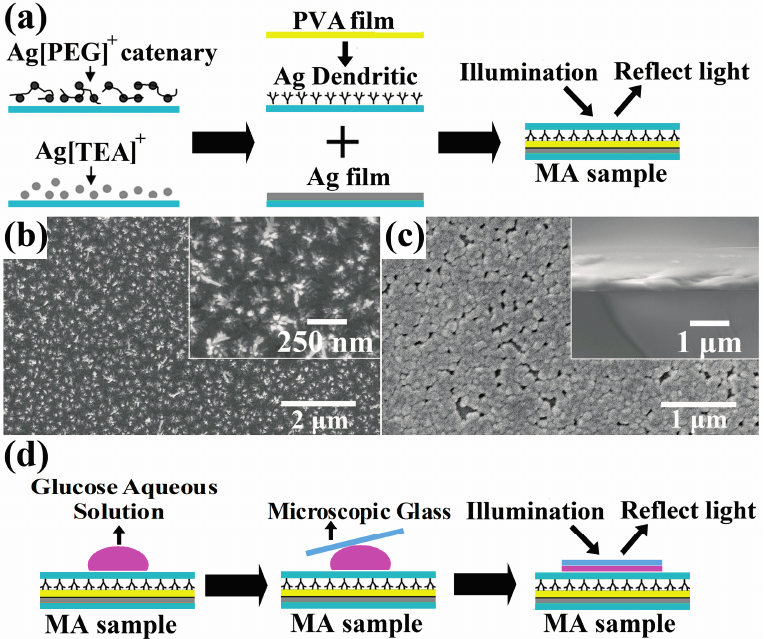
Figure 1. ( a ) The fabrication process of the multiband visible MA; ( b ) Scanning electron microscope (SEM) image of the prepared silver dendritic units—the illustration is an enlarged drawing of silver dendritic units; ( c ) SEM image of the silver metal plane—the inset is the cross-section of the silver metal